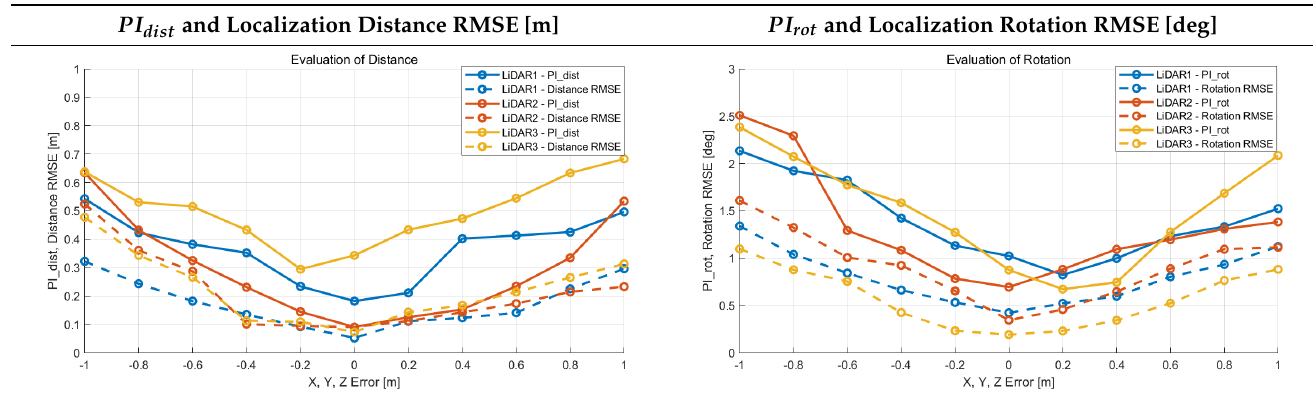
Table 7. Result of experiement using real